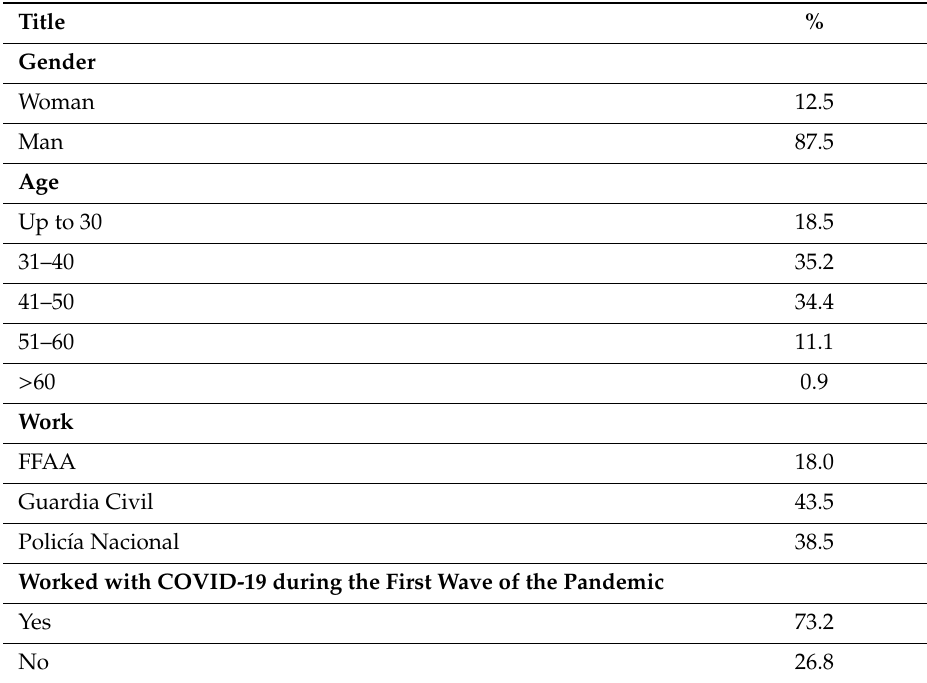
Table 1. Sociodemographic characteristics of the